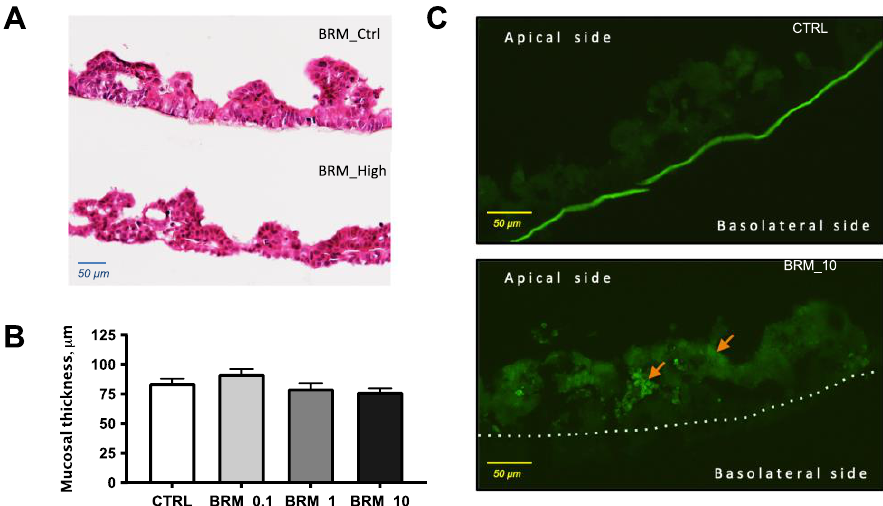
Figure 6. Representative photomicrographs of H&E-stained tissue samples from the untreated control ( upper ) and treated with 10 mg/mL BRM ( lower ) ( A ); mucosal thickness measured from the tip of villi-like structure to the membrane ( B ); photomicrographs of fluorescent samples from untreated control ( upper ) and treated samples with 10 mg/mL BRM ( lower ) showing presence LY marker in the mucosa by arrows ( C ).